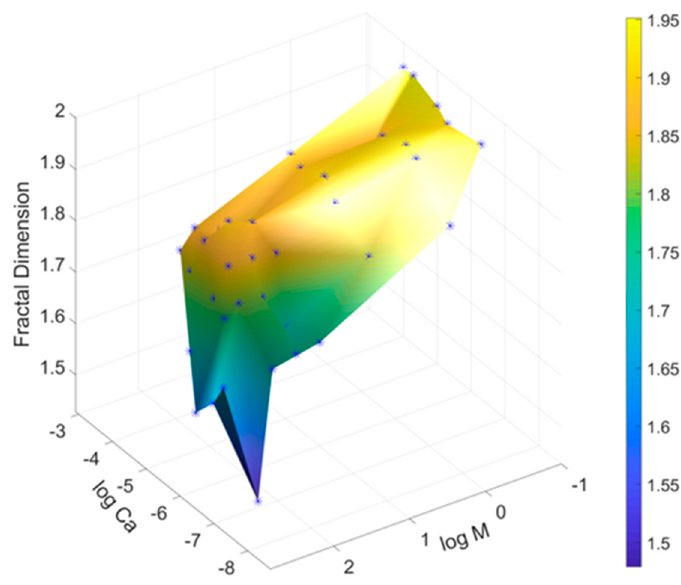
Figure 4. Drainage fractal dimension versus log M and log Ca.